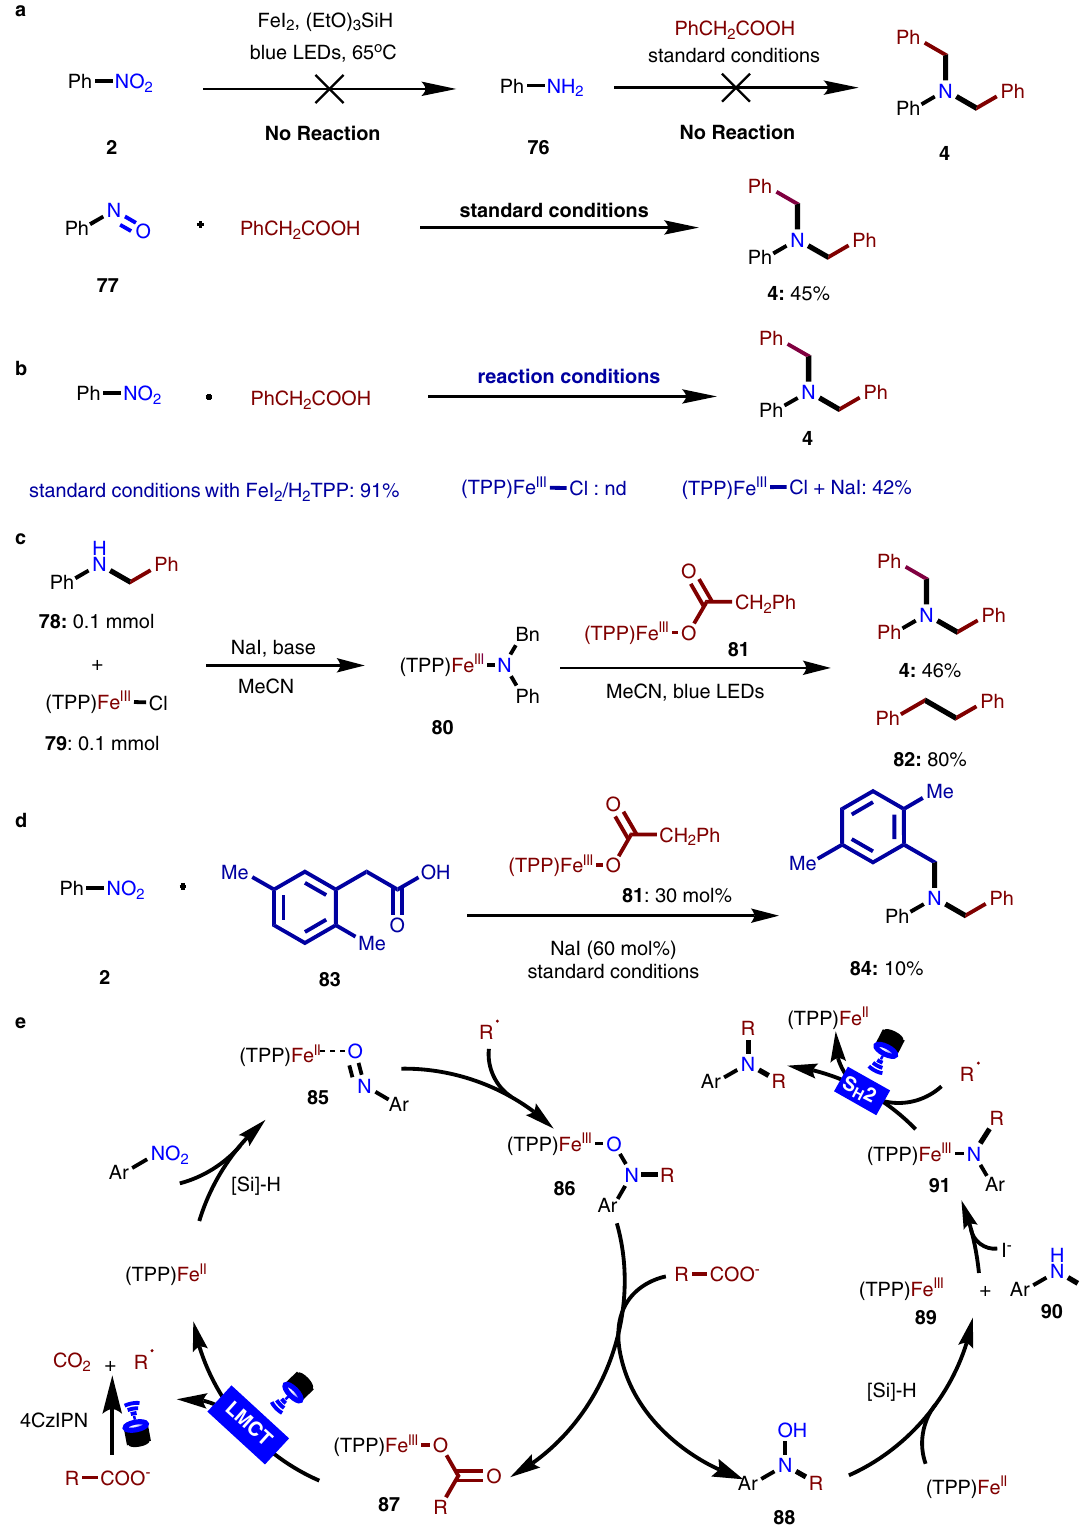
Fig. 5 Mechanism study. a Controlled experiment. b Effects of various iron catalysts, ligand L1 , and additive NaI on reaction and the study of S H 2. c Cross- over experiment between 80 and 81 . d The three-component cross-coupling. e Plausible